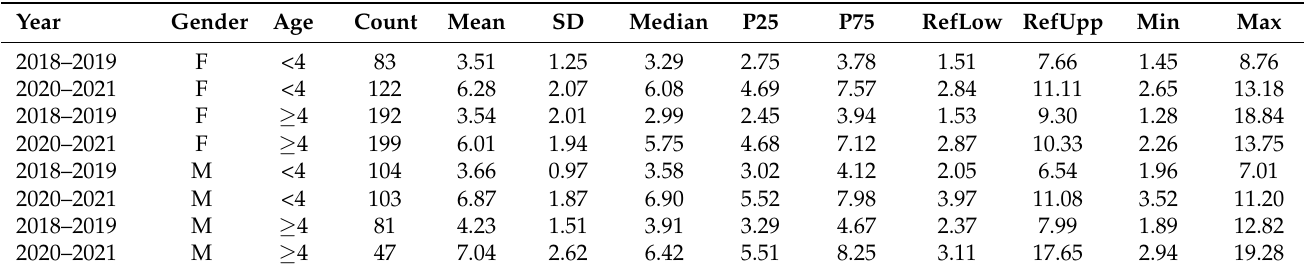
Table 8. Glucose values in cynomolgus macaques in mmol/L. In 2018–2019, ketamine was used as a sedation protocol, and in 2020–2021, ketamine combined with medetomidine was used as a sedation protocol.